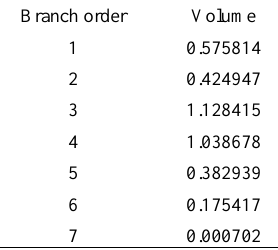
Table 3. Branch volumes of tree